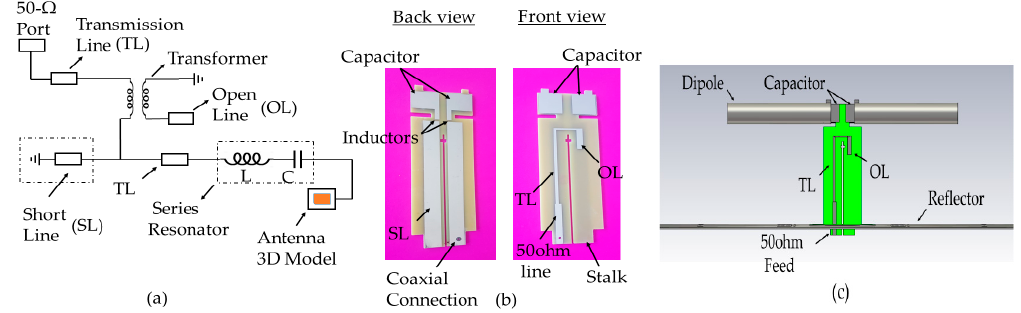
Figure 7. ( a ) Circuit representation of the matching circuit for the feed. ( b ) Microstrip implementation of the matching circuit ( c ) Side view of the radiating element.